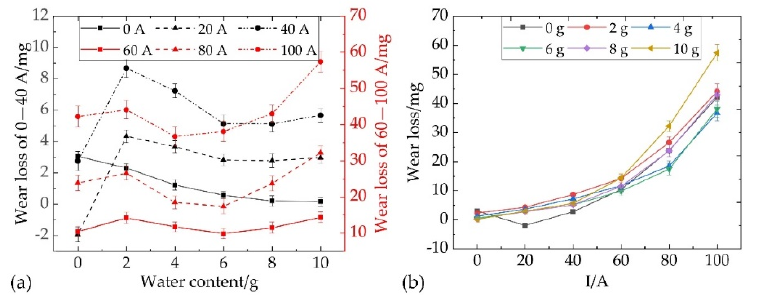
Figure 4. Effect of water content on wear loss of C-Cu contacts: ( a ) under different currents; ( b ) under different water content.